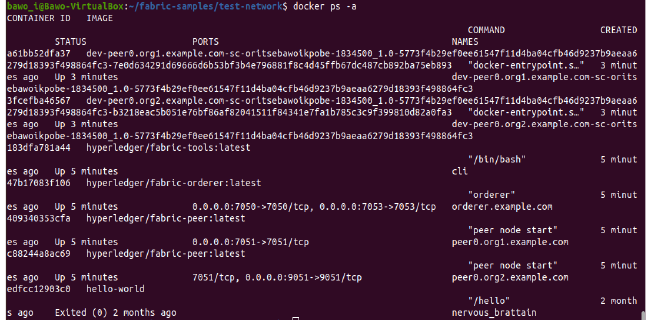
Figure 8: Test network components implemented in Hyperledger Fabric.